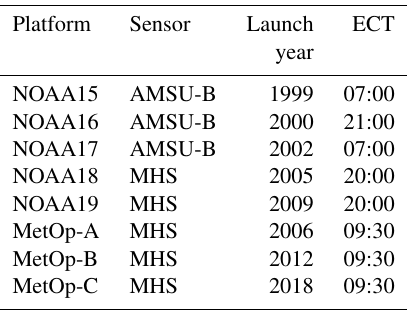
Table 2. Humidity sounders in orbit, with platforms, launch year and approximate Equator crossing times